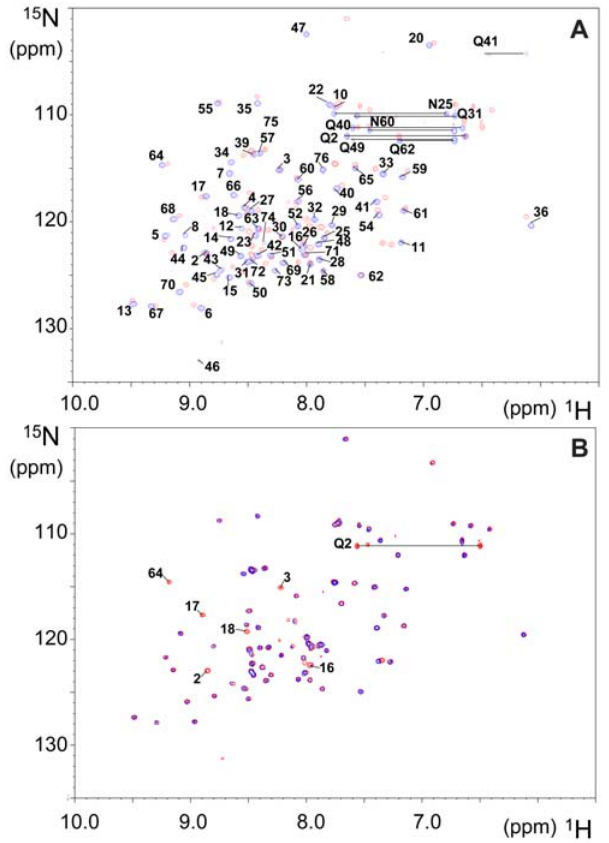
Figure 8. Paramagnetic Cu II broadening effects in NMR spectra of Ub in TFE. A) Overlay of 1 H, 15 N HSQC spectra of Ub in 50 mM ammonium acetate buffer at pH 6.5 (blue contours) and Ub in the same buffer with 20% TFE (red contours). Backbone amide cross-peaks and side-chains of Gln/Asn are labeled; B) Overlay of 1 H, 15 N HSQC spectra of Ub in 50 mM ammonium acetate buffer at pH 6.5 with 20% TFE before (red contours) and after (blue contours) addition of 0.1 mol equiv of Cu II . Cross-peaks that disappear after Cu II addition are